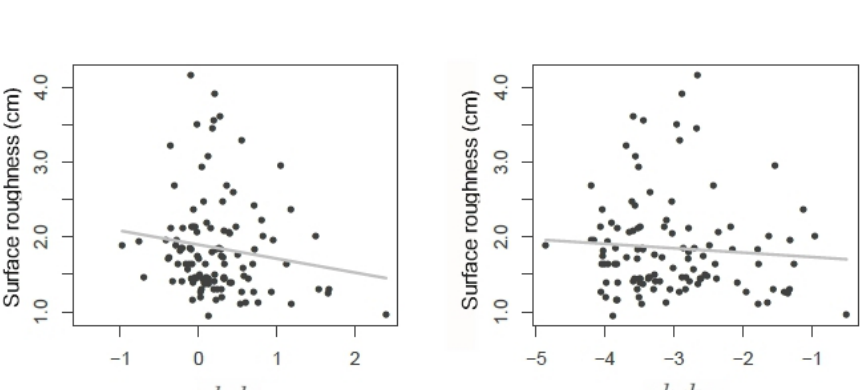
) (cm) versus horizontal and vertical RMS , σ (dB) (upper panels) and derived variables dvh, dvh hh vv